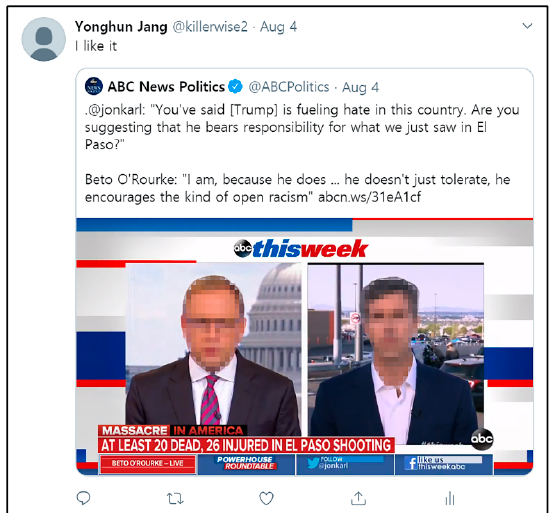
Figure 3. An example of using Quote Retweet.